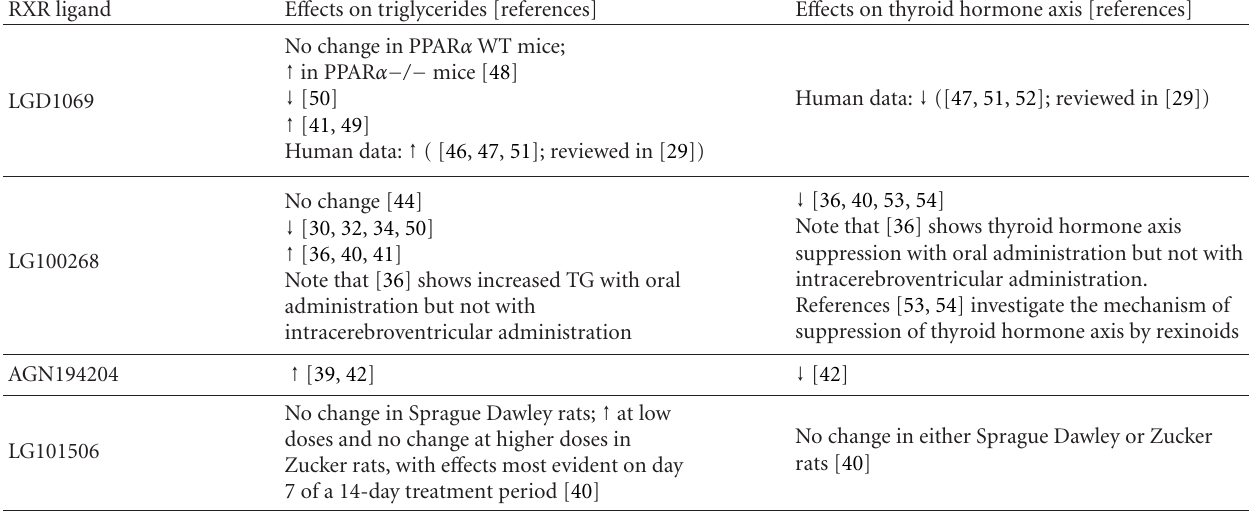
Table 3: Summary of the e ff ects of RXR-specific ligands on hypertriglyceridemia and suppression of the thyroid hormone axis. RXR